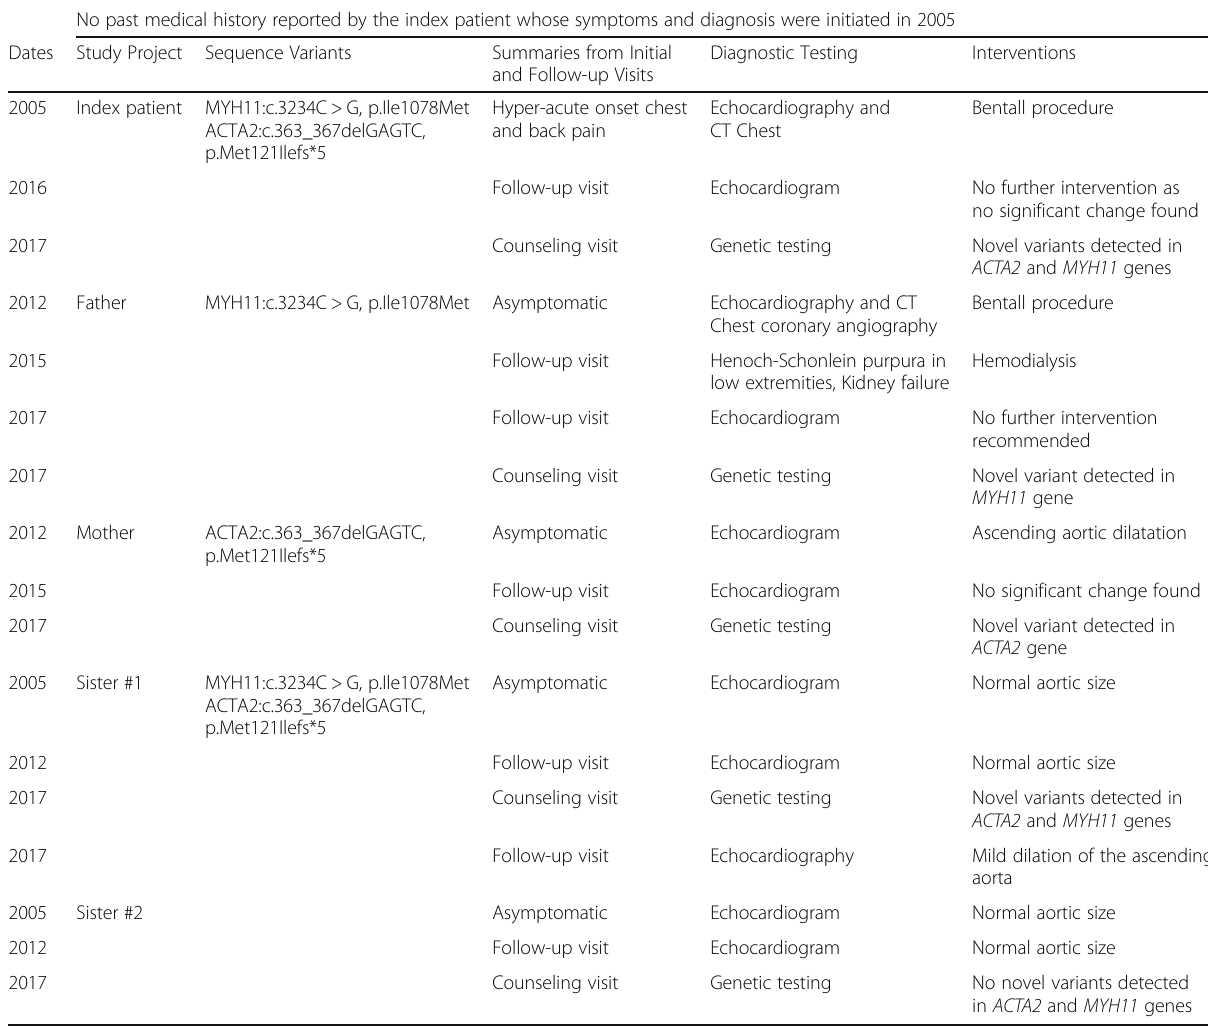
Table 1 The index patient ’ s and the family ’ s medical diagnosis and interventions Relevant Past Medical History and Interventions No past medical history reported by the index patient whose symptoms and diagnosis were initiated in 2005 Dates Study Project Sequence